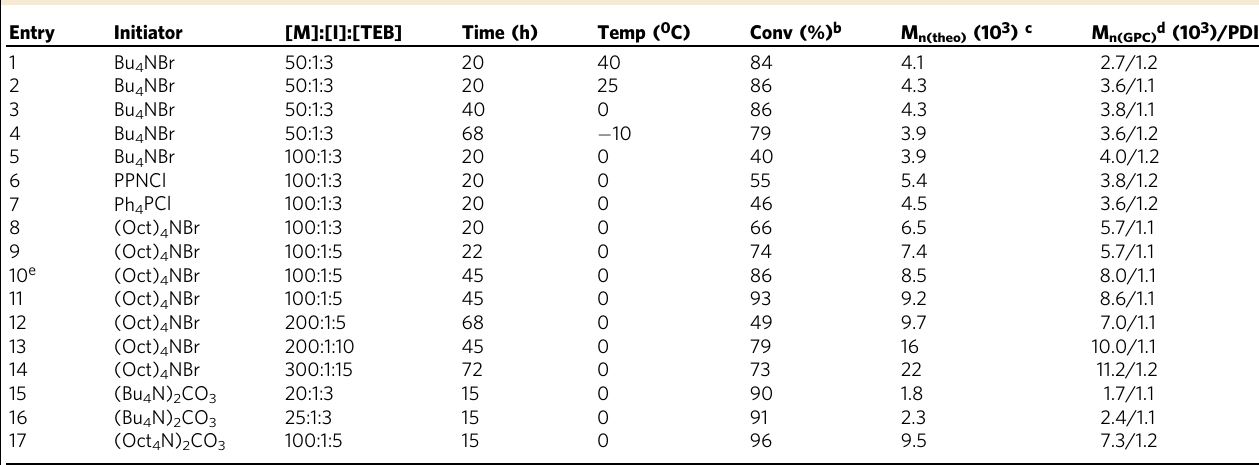
Fig. 2 1 H NMR spectra showing the activation of GA by TEB. a Shows the 1 H NMR spectrum of GA. b Displays the interaction of TEB with the epoxide and namely with its azido group as indicates the down fi eld shift of the methylene protons of the epoxide (H a ) and of its azido group (H c ) Table 1 Triethyl borane-assisted homopolymerization of glycidyl azide